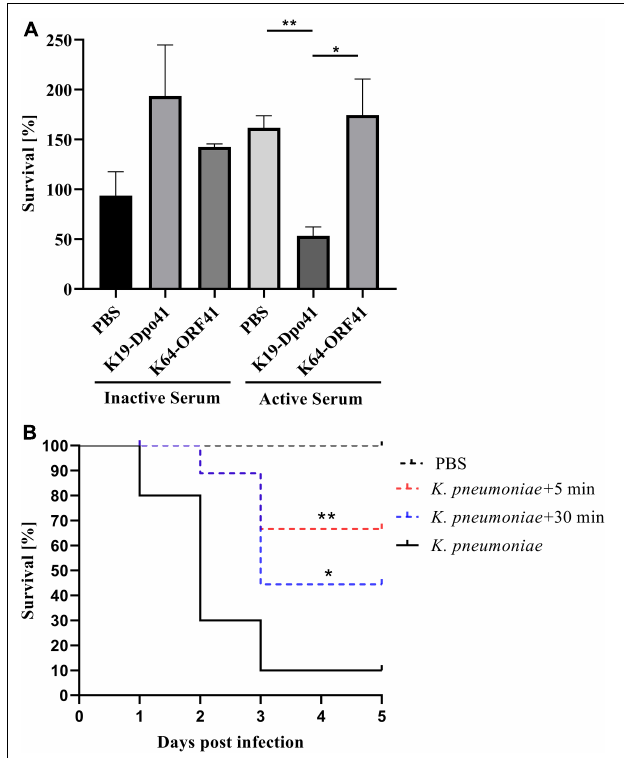
FIGURE 4 | Anti- k. pneumoniae infection effect of K19-Dpo41. (A) Effect of K19-Dpo41 on bacterial susceptibility to serum killing. K. pneumoniae strain 6570 treated with K19-Dpo41 were incubated with active or heat-inactivated human serum obtained from healthy volunteers for 1 h at 37 ◦ C. A control group with no K19-Dpo41 was included. A specificity group with K64-ORF41, another depolymerase specifically targeting the CPS of K64-type K. pneumoniae , was also included. The survival rate was defined as the average percent survival of bacteria relative to the initial population. The experiment was repeated three times. Error bars represent mean ± SD. The individual survival rates of each group were compared by Student’s t test. ** P < 0.01, * P < 0.05. (B) Effect of K19-Dpo41 on larvae survival rate in a Galleria mellonella larvae infection model. Black solid line, Larvae injected with 5 × 10 4 CFUs K. pneumoniae strain 6570; red dotted line, K19-Dpo41 (final concentration, 2 µ g per larva) administered 5 min after 5 × 10 4 CFUs K. pneumoniae strain 6570 inoculation; blue dotted line, K19-Dpo41 (final concentration, 2 µ g per larva) administered 30 min after 5 × 10 4 CFUs K. pneumoniae strain 6570 inoculation; black dotted line, Larvae injected with PBS. The mortality were monitored for 5 days ( n = 10). Results are the means of three independent experiments. Survival curves were plotted using the Kaplan–Meier method, and differences in survival were calculated by using the log-rank test (GraphPad). ** P < 0.01 and * p < 0.05, mean a significant difference to the K. pneumoniae strain 6570 infected